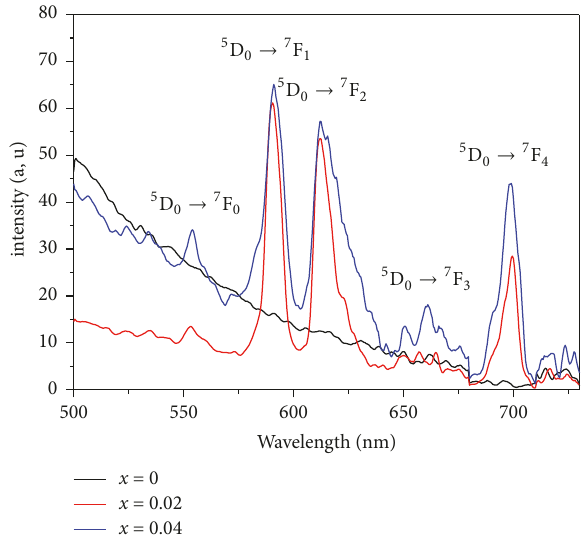
=394nmofLiGd (1 ex